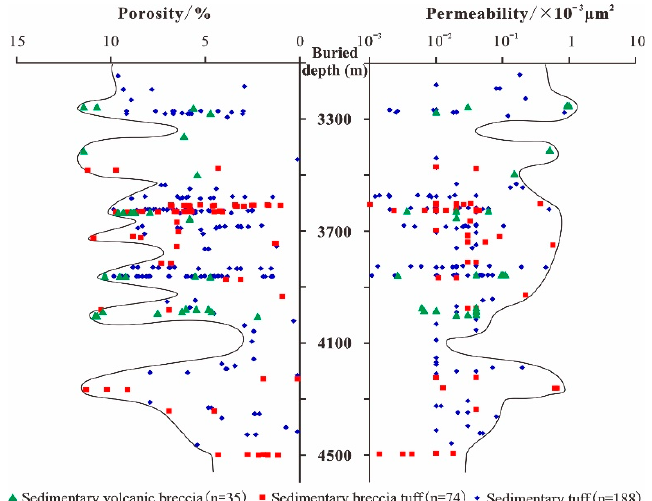
Figure 4. Relation between porosity–permeability and buried depth of sedimentary pyroclastic rocks reservoirs in K 1 y 2 , YFD.